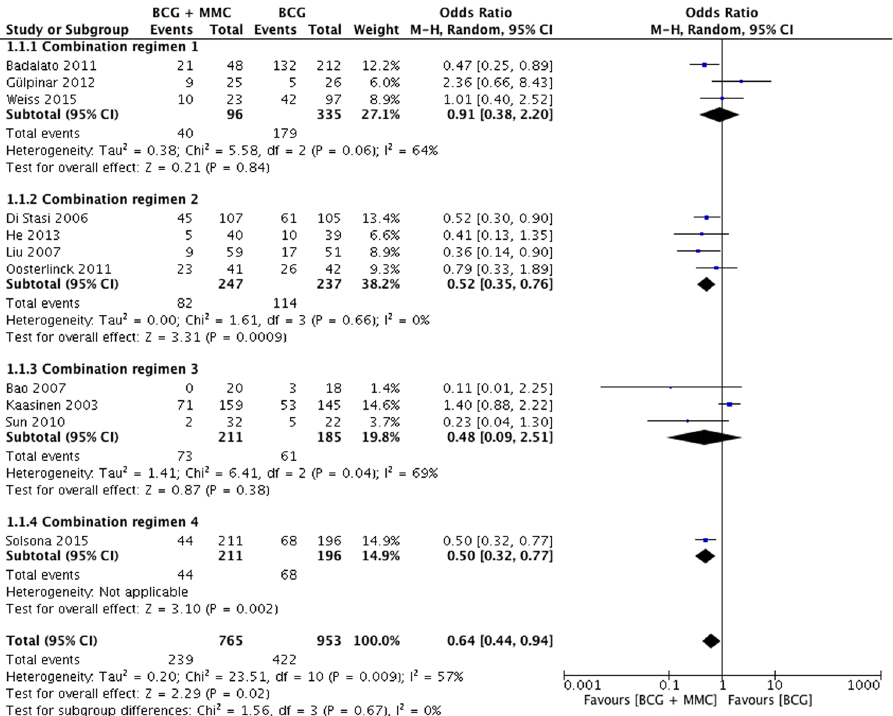
Figure 3. Forest plot of tumor recurrence rate comparing combination therapy with BCG